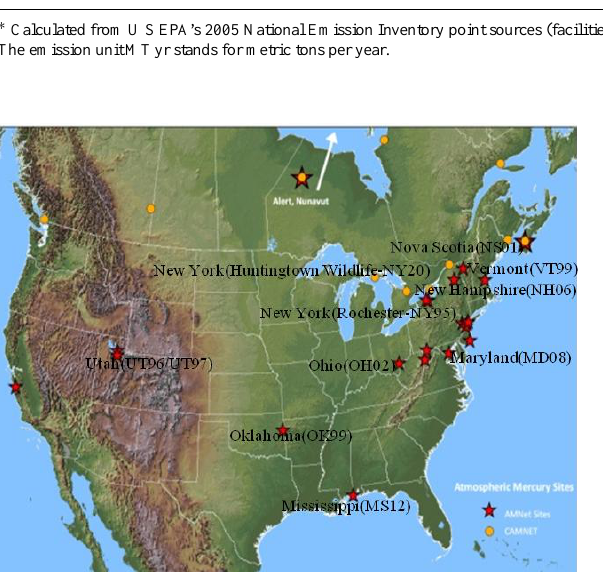
Figure 1. Location of the 11 AMNet sites utilized in this study. Fig. 1. Location of the 11 AMNet sites utilized in this study. This map is modified from AMNet site map available on: http://nadp.